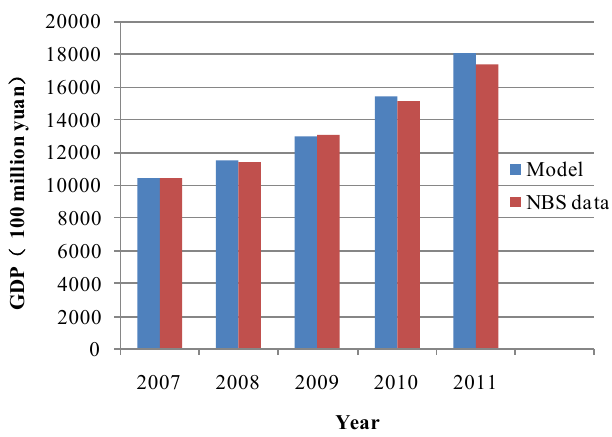
Fig. 6. GDP of Sichuan Province from 2007 to 2011 according to NBS data and scenario S 1 of the CGE model.